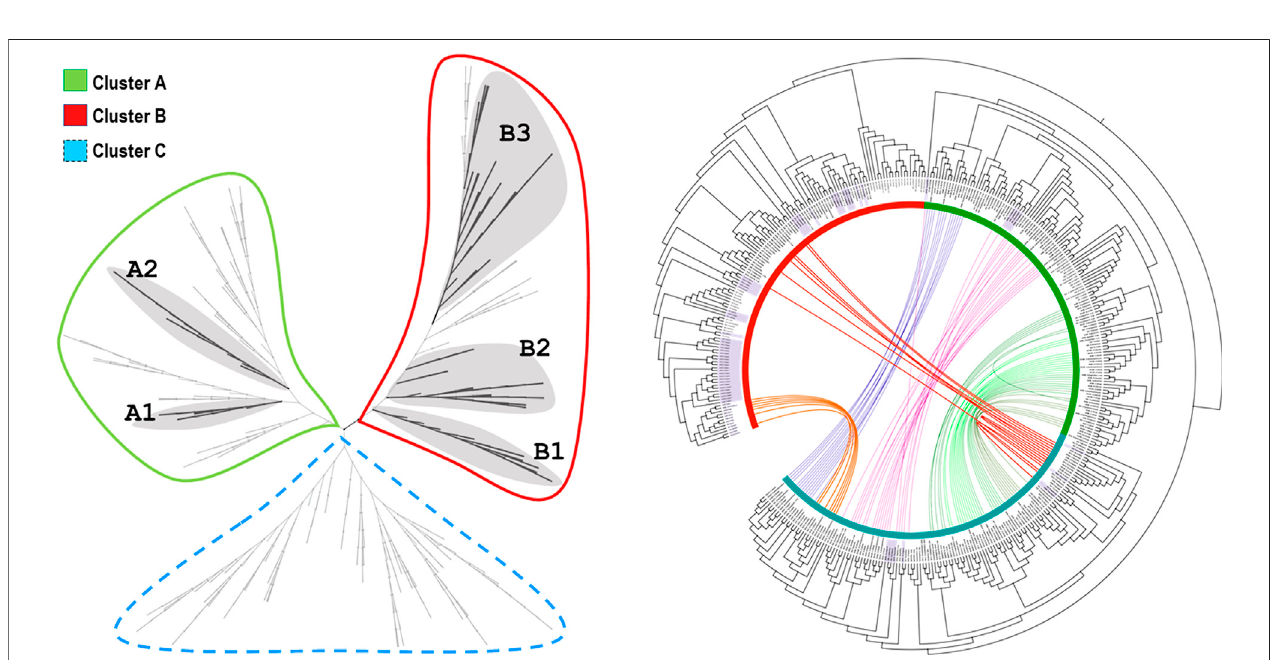
FIGURE4| MLtreegeneratedusingthemultiplesequencealignmentoftheACDdataset (A) Left,unrootedMLphylogenetictreeandclusteringbranchingpattern ofmonomericsHsps(shadowedclades) (B) Right,circularMLphylogenetictreeshowingthelocationoftheoutgroups ’ ACDs(shadowedlabels),thecoloredconnection lines between the ACDs belonging to the same dimeric protein, and the colored stripes (green, red and blue) marking the three big clades: Cluster A, B and C, respectively. Branch lengths are not displayed. More details can be found in File S2, including the results of the Bayesian phylogenetic study, the dendrograms of the analyzed clusters, and the node support